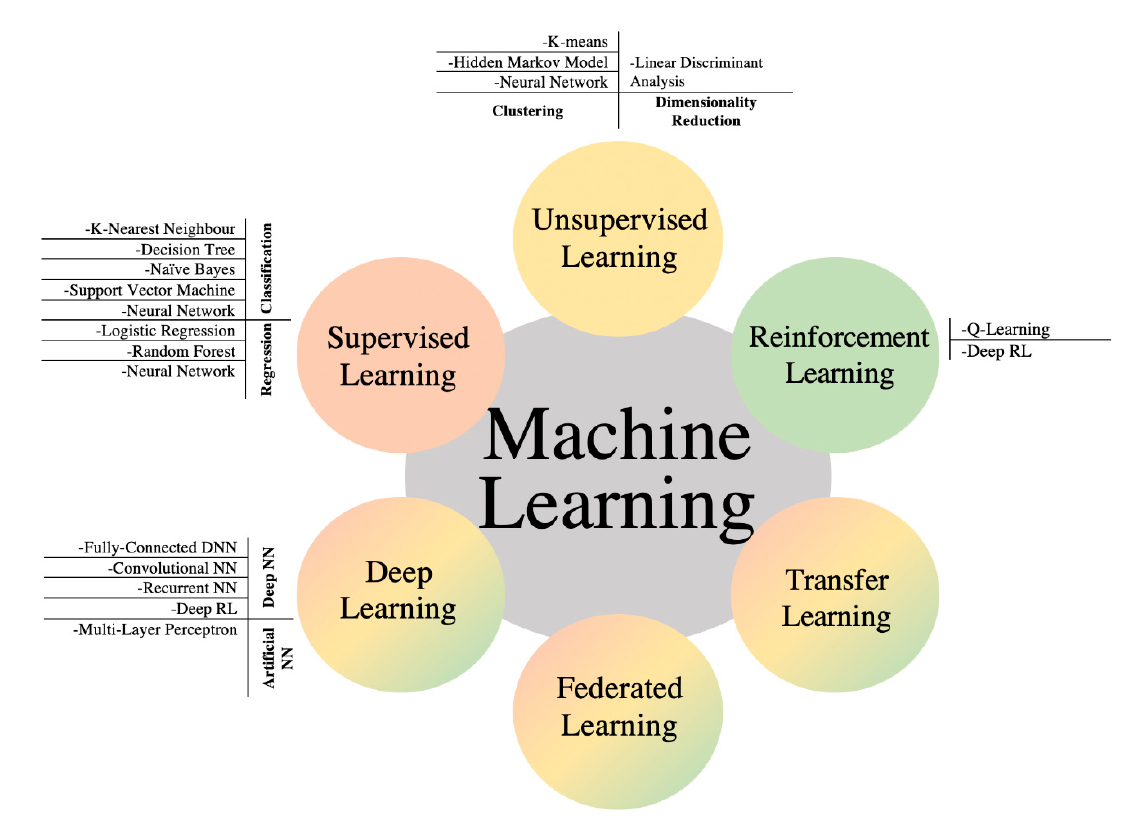
Figure 2. Machine learning models for VANET [11].